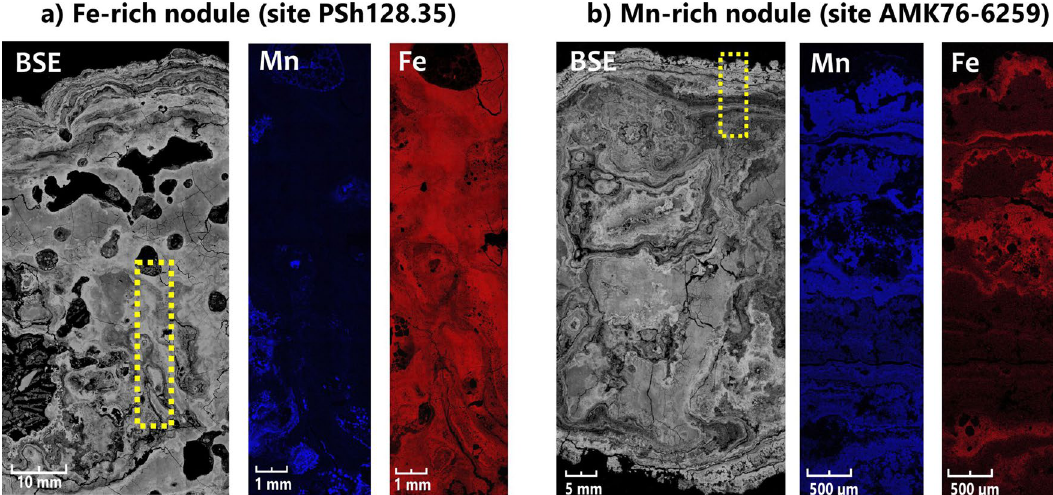
Figure 2. Growth structures and elemental map in nodule samples from sites PSh128.35 and AMK76- 6259. Yellow dotted rectangles show the areas of elemental mapping (Mn and